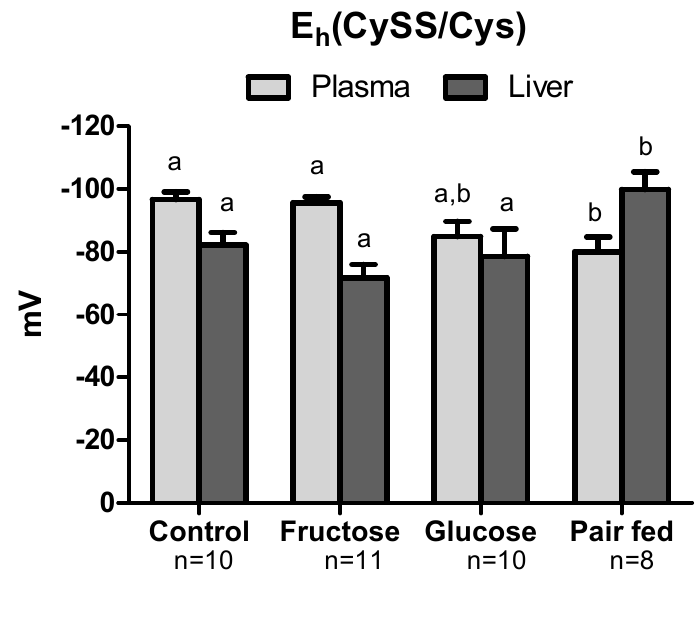
Figure 4. Cys/CySS redox potential (E using Nernst equation and expressed in mV. Different letters (a,b) indicate statistically significant difference among respective groups. In the pair fed group, the E oxidized in plasma, while reduced in liver compared to other groups, indicating differential plasma but not hepatic oxidative